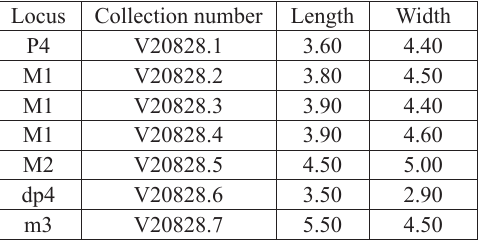
Table 5. Measurements (in mm) of cheek teeth of Asiomys dawsoni .